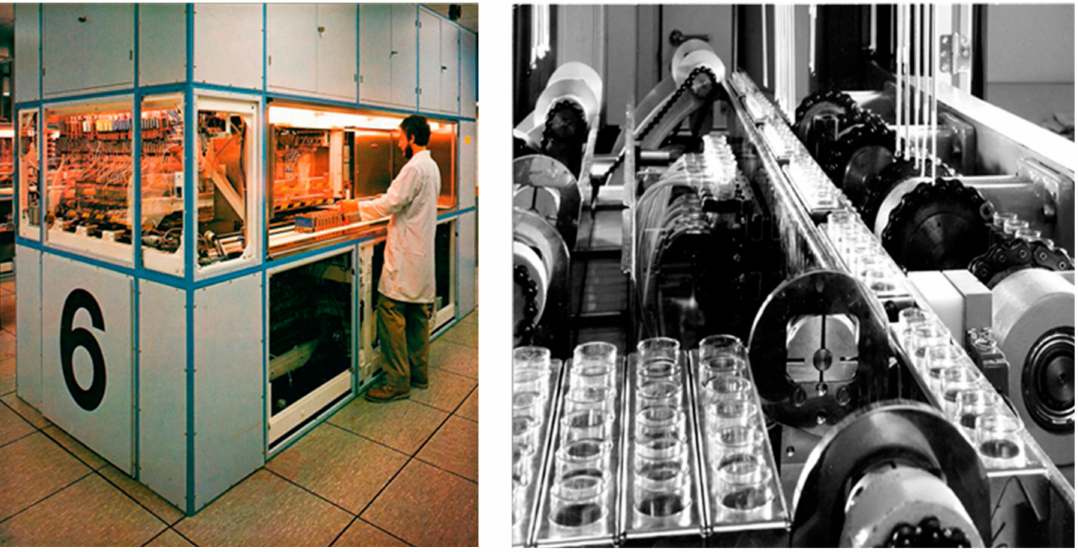
Figure 8. The Autochemist,